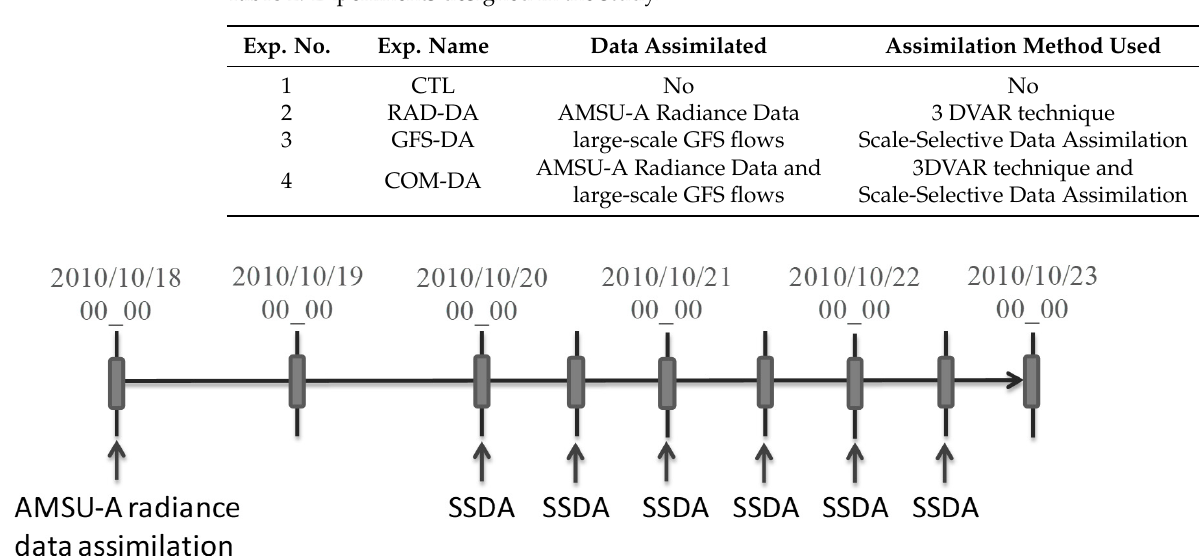
Figure 2. The model domains of the WRF used for all experiments. Table 2. Experiments designed in the study.